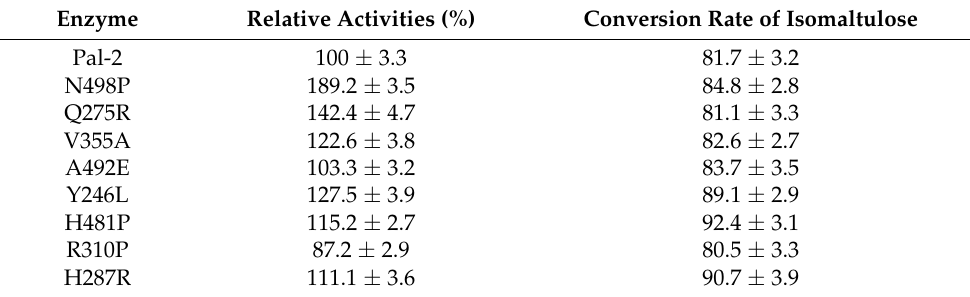
Table 5. Relative activities and the conversion rate of isomaltulose. Enzyme Relative Activities (%) Conversion Rate of Isomaltulose Pal-2 100 ±